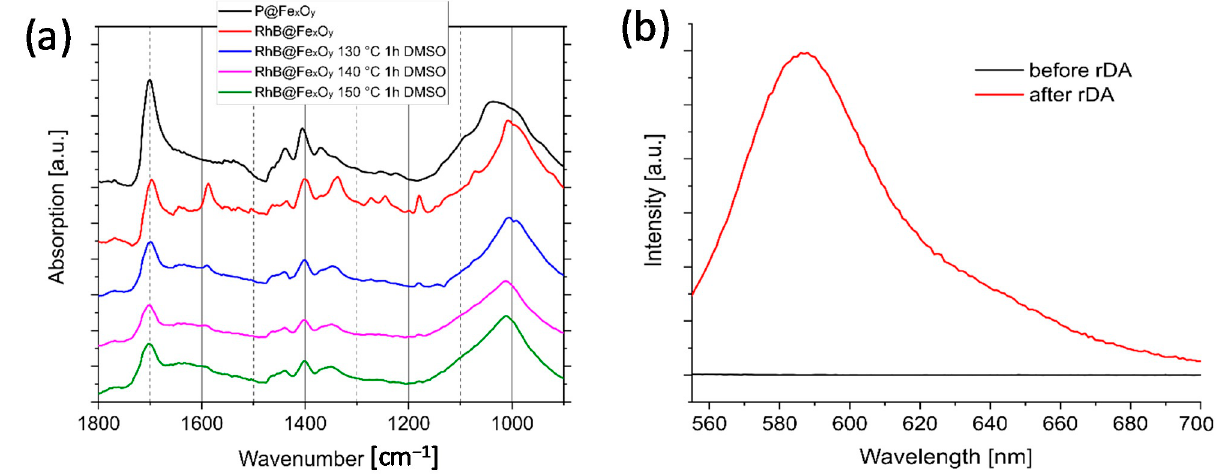
Figure 9. ( a ) FTIR spectroscopy of the RhB@Fe x O y samples treated at rDA conditions; ( b ) fluorescence spectra before and after the rDA reaction at 130 °C.